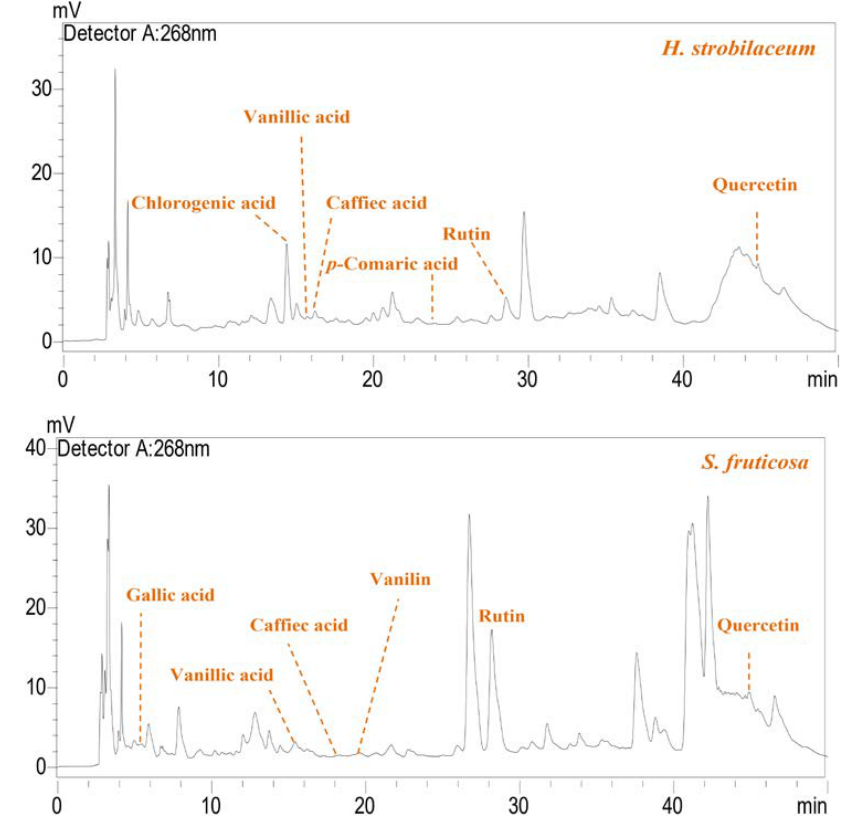
Figure 1. RP-HPLC chromatogram of the identified phenolic compounds in the hydro-methanolic extracts ( H. strobilaceum and S. fruticosa